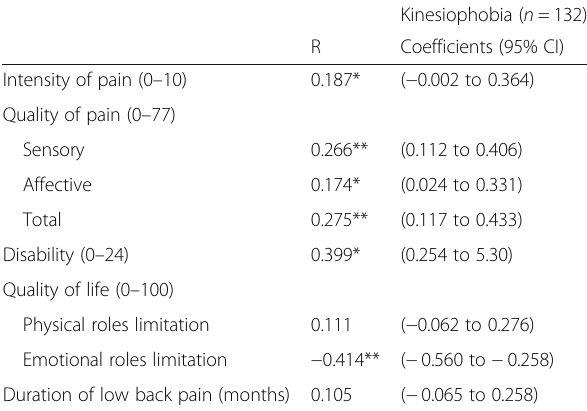
Table 2 Correlation between kinesiophobia and the measured clinical